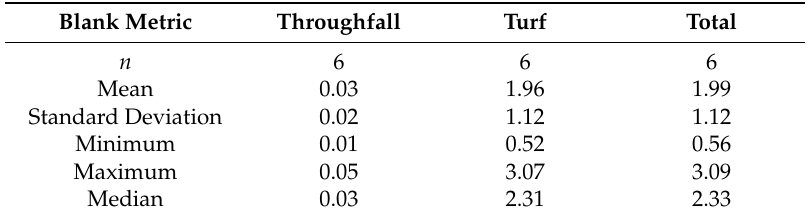
Table 1. Summary of total Hg ATSS field blanks at Michigan sites